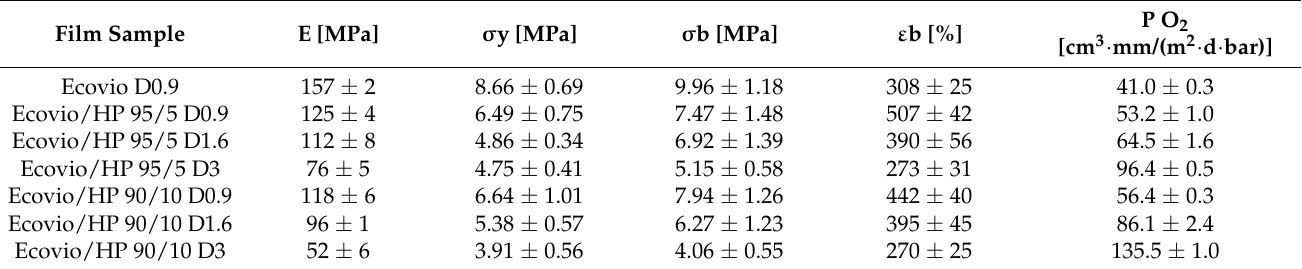
Table 7. Tensile mechanical parameters and permeability to oxygen of films with different composi- tion and average thickness.